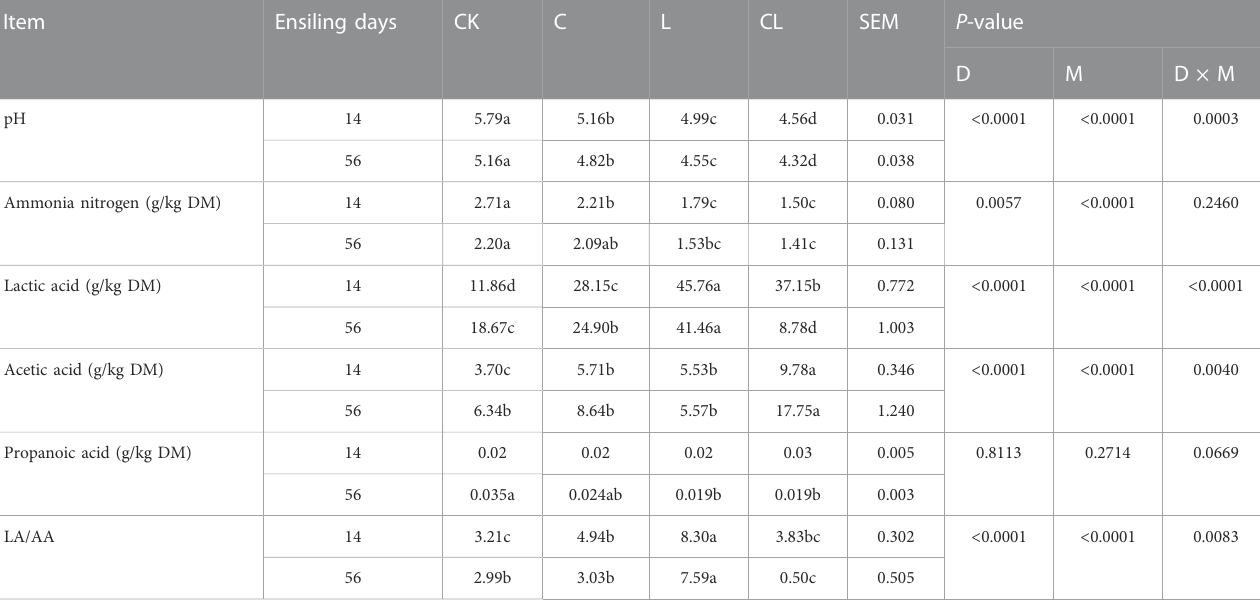
TABLE 3 Effect of cellulase and Lactiplantibacillus plantarum on the fermentation products of Caragana korshinskii silage. Item Ensiling days